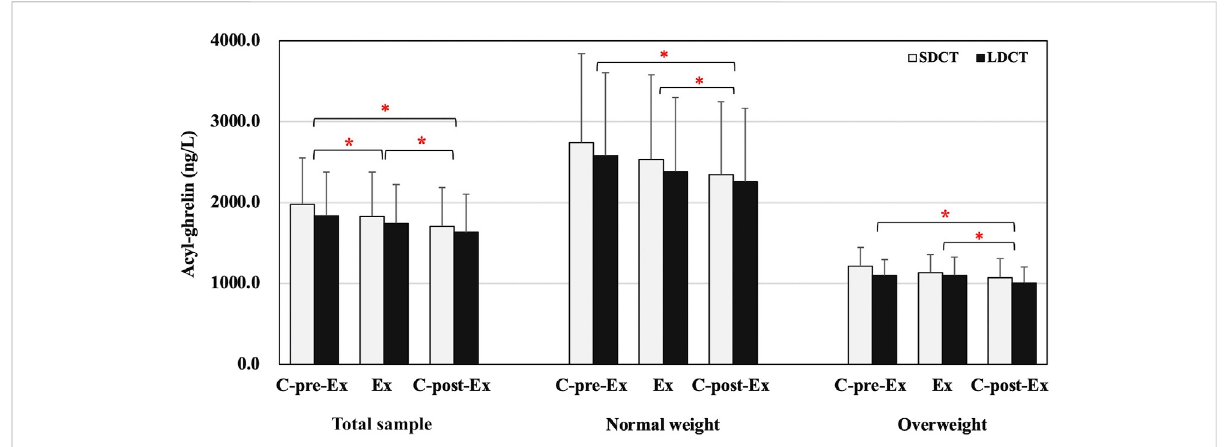
FIGURE 4 Acyl-ghrelin in the total sample, normal and overweight adults. Data are expressed as the mean ± SEM. *Present the main effect of time, p < 0.05. Abbreviation: SEM, standard error of the